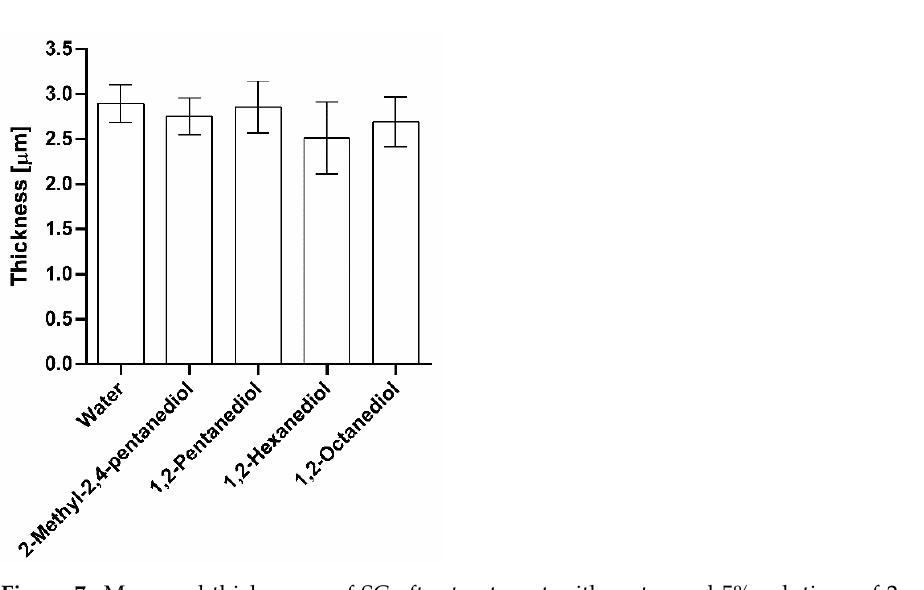
Figure 8. C-C skeleton vibration mode: calculation of ratio for lipid order analysis, after treatment with water and 5% solutions of 2-methyl-2,4-pentanediol, 1,2-pentanediol and 1,2-hexanediol, and saturated 1,2-octanediol solution, n = 9, mean ± SD, ** p ≤ 0.01; **** p ≤ 0.0001. 1,2-Pentanediol and 2-methyl-2,4-pentanediol do not show a significant effect on the lipid order compared to the water reference. In contrast, the longer-chained alkanediols,